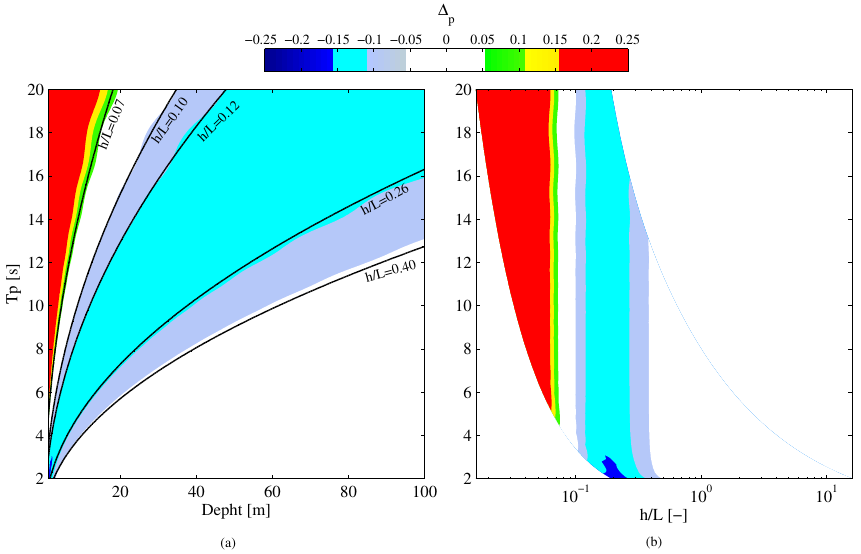
Figure 6. Comparison between Eqs. (3) and (4): (a) the relative difference (cid:49) P is plotted as function of the peak period and the depth (the lines indicate the ratio between the depth and the wavelength.); (b) the relative difference (cid:49) P is plotted as function of the peak period and the ratio h . L